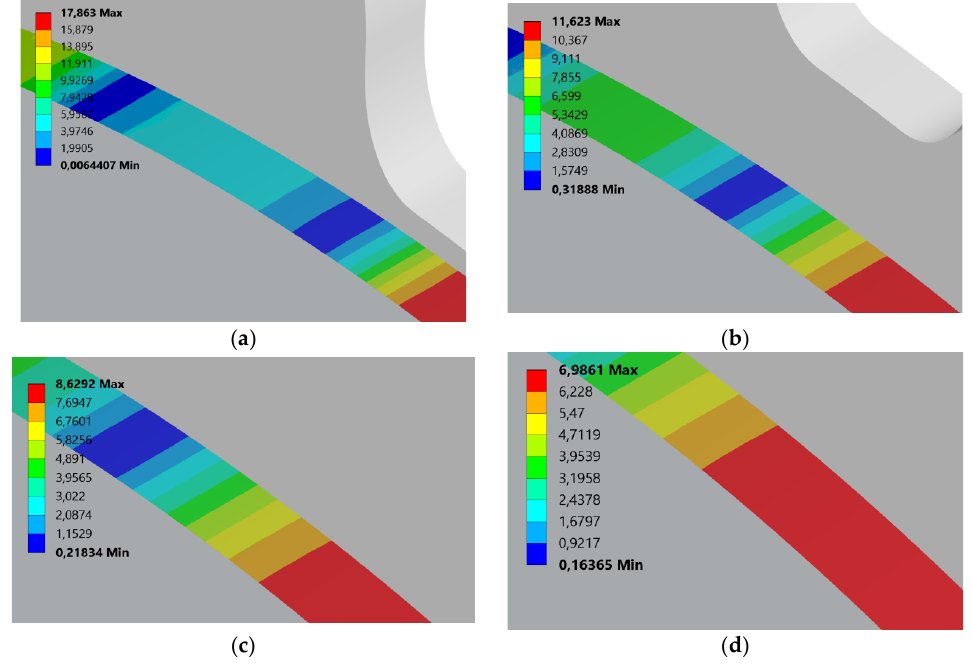
Figure 14. Shear stress results for hybrid gears generated rack tip radius, ρ 1 = 0.1 xm for different RTs; ( a ) 0.5 xm, ( b ) 1 xm, ( c ) 1.5 xm, ( d ) 2